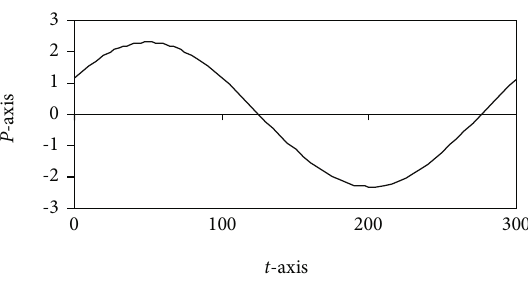
Figure 1: The analytical solution P against the time t .